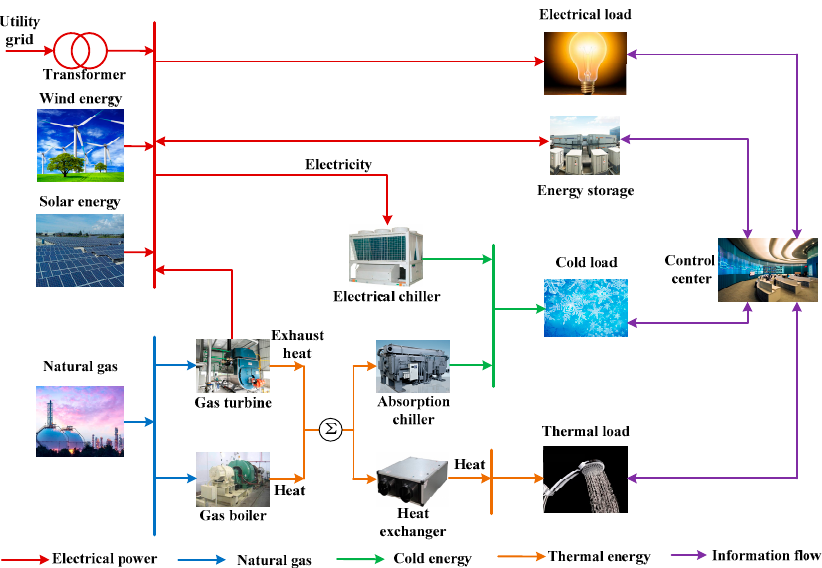
Figure 1. Typical MES topology diagram.